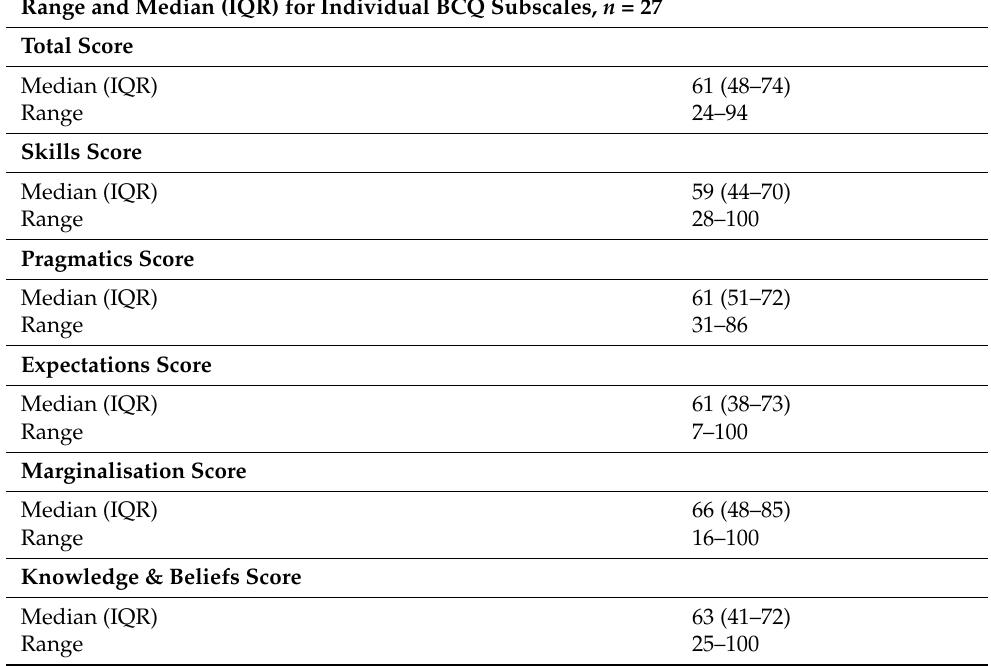
Table A5. Barriers to Care Questionnaire scores relation to healthcare diagnostic